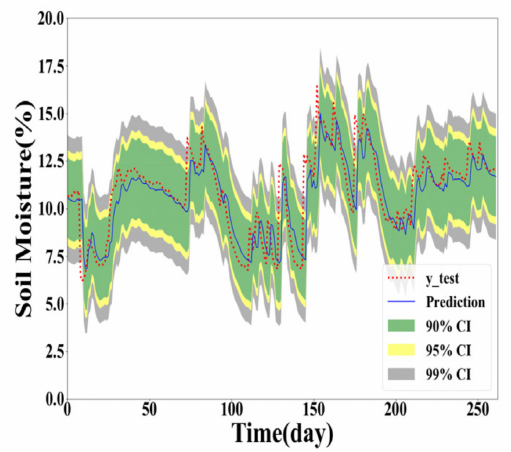
Figure 9. GPR model built with the chosen data in Y(2) prediction.